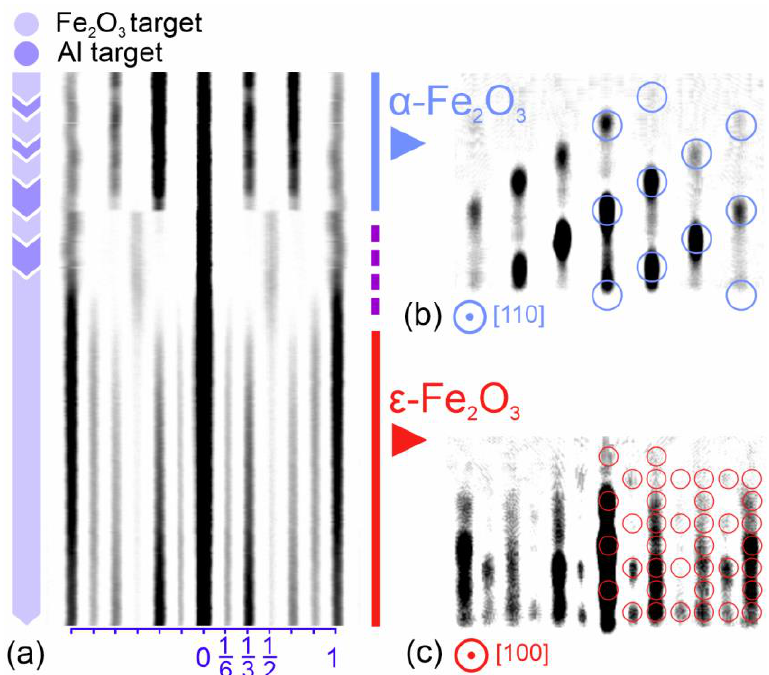
Figure 3. Time-dependent RHEED profile map ( a ) showing trigonal-to-orthorhombic transformation at the initial stage of aluminum-assisted nucleation of ε -Fe 2 O 3 on Al 2 O 3 . The map height corresponds to deposition of about 20 Å of Fe 2 O 3 . The corresponding RHEED patterns of α -Fe 2 O 3 ( b ) and ε -Fe 2 O 3 ( c ) illustrate the initial and final stages of the nucleation